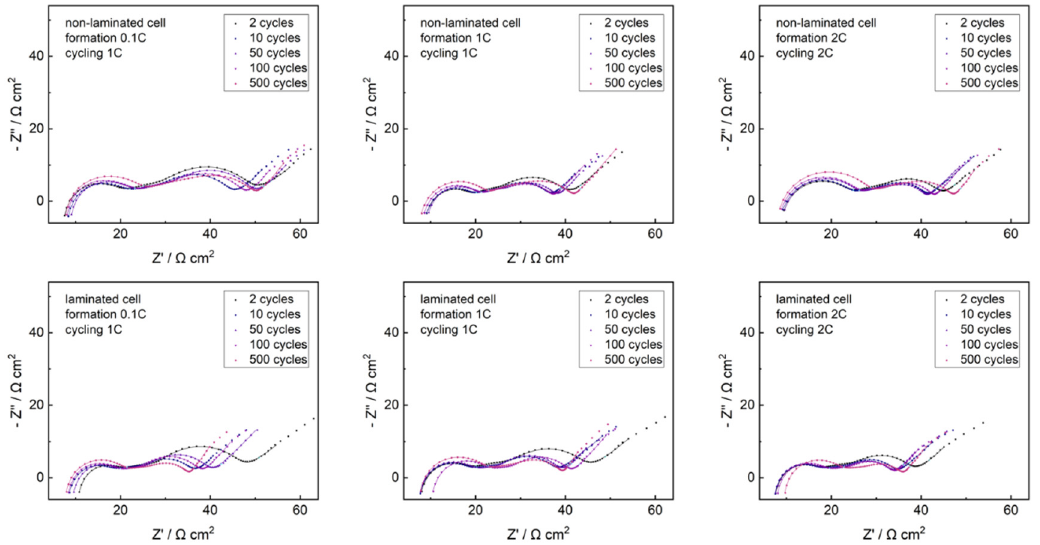
Figure 6. Impedance measurements of non-laminated / laminated cells: electrochemical impedance spectroscopy (EIS; 50 kHz–10 mHz) along cycling test (500 cycles total) after varied formation rate (2 initial cycles); fitting curves indicated as solid lines; data points at 940 Hz and 0.104 Hz highlighted in pale blue; data normalized to geometric electrode area.